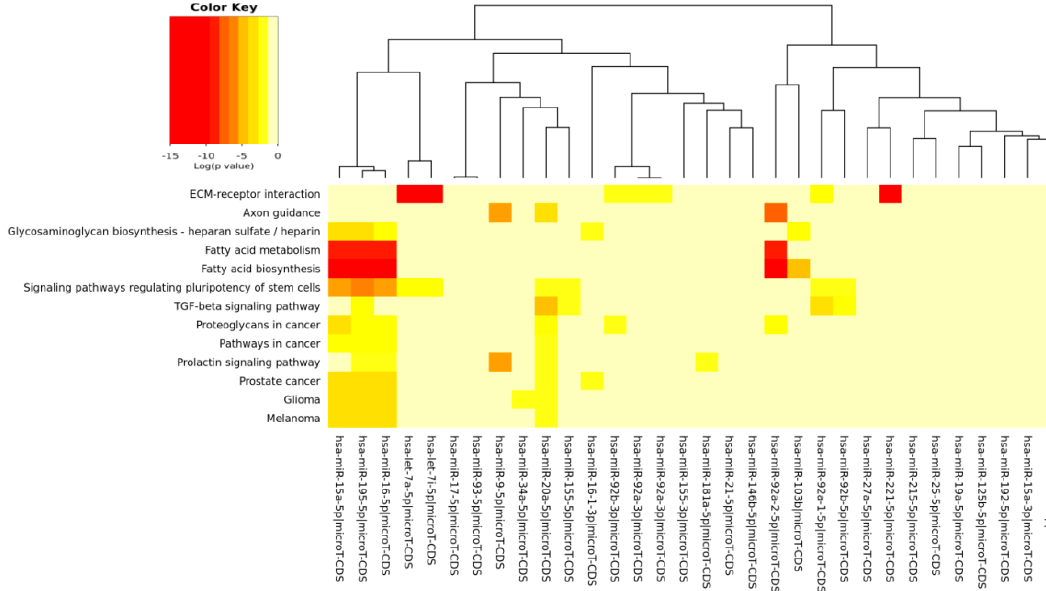
Figure 4. MicroRNAs involved in DDR and modulated by CRC versus the pathways’ heat map. In this plot, heat map calculation is based on absolute p -values. Darker colors represent lower p -values (higher significance). The plot shows microRNAs targeting similar pathway clusters and pathways being targeted by miRNA groups.